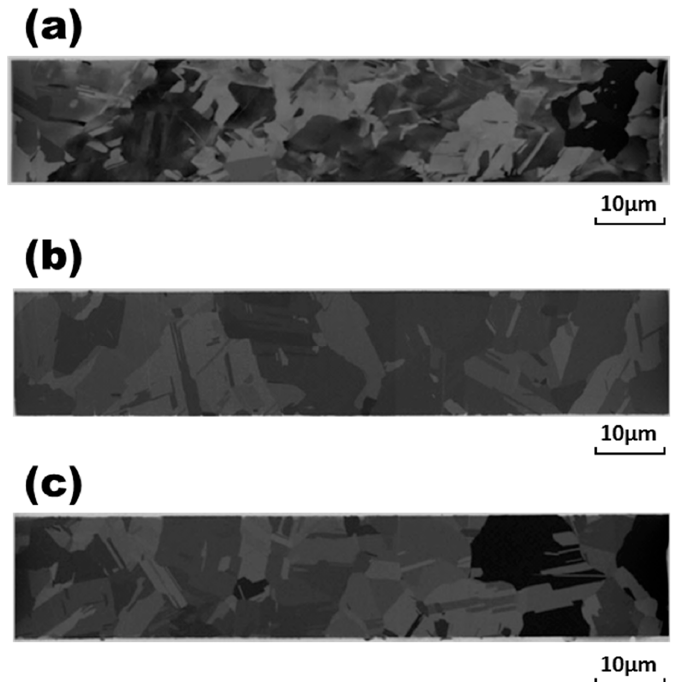
Figure 2. FIB image shows the grain structures in longitudinal cross ‐ sections of the Ag wire after current stressing at 1.23 × 10 5 A/cm 2 for various times: ( a ) original; ( b ) 1 h; ( c ) 20 h.